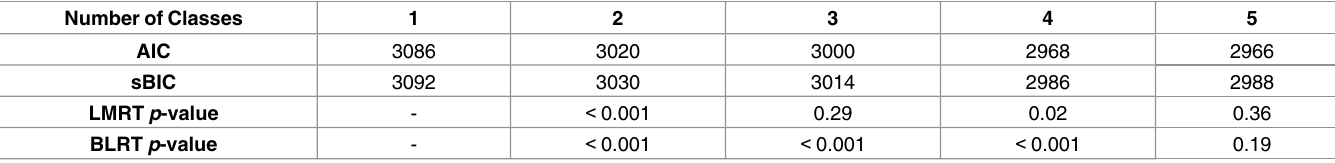
Table 6. Latent Profile Analysis (LPA) Model fit